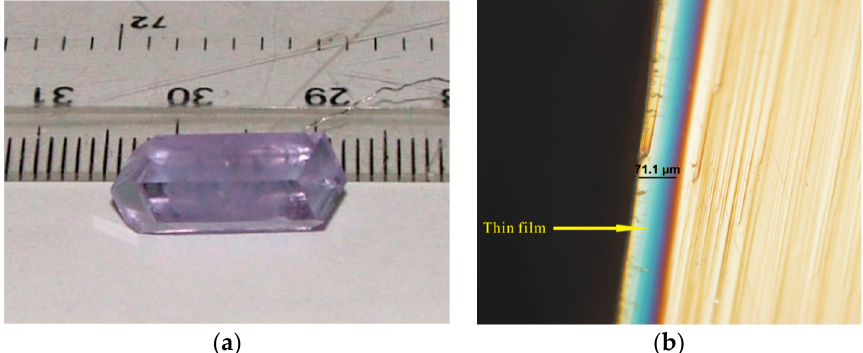
Figure 3. ( a ) As-grown bulk Nd:YAB crystal and ( b ) differential interference contrast image of the Nd:YAB thin film and YAB substrate in cross-section.